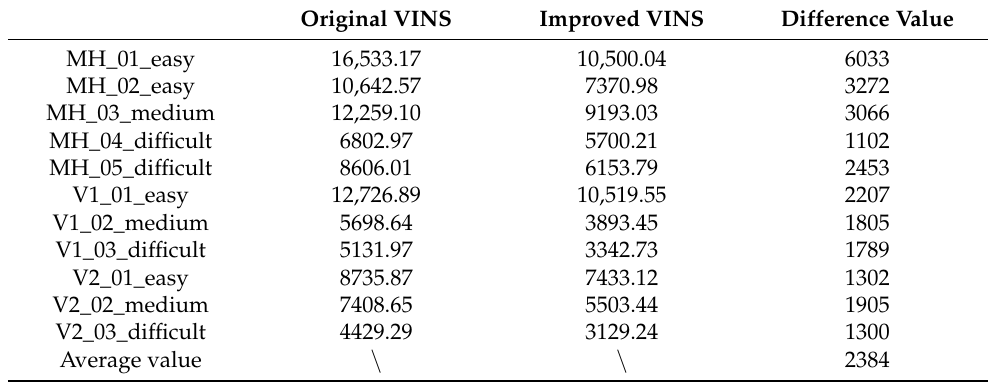
Table 14. Comparison of the marginalization speed between the original algorithm and the optimized algorithm in the EuRoC dataset (unit: ms).